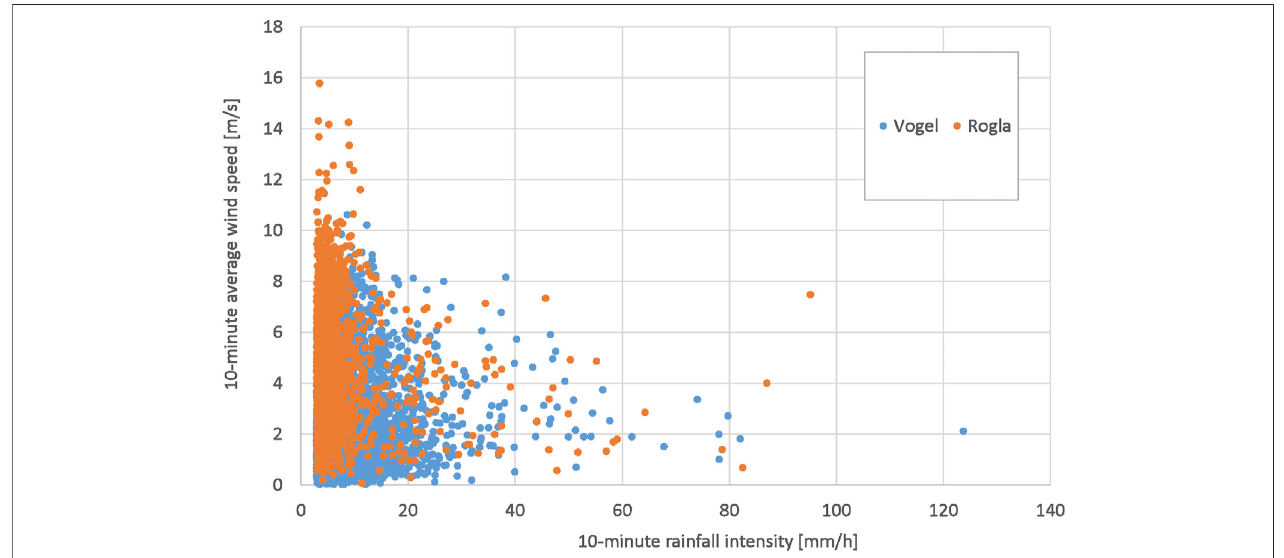
FIGURE 10 | Relationship between 10 min wind speed and rainfall intensity for Vogel and Rogla stations that have wind speed measurements available. Only intensities larger than 3 mm/h are shown.